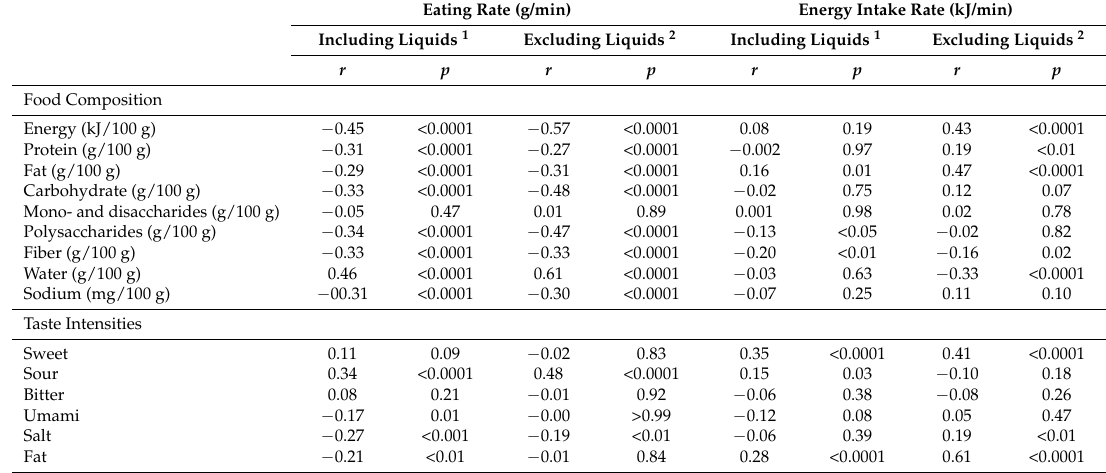
Table 1. Pearson correlations between food-specific eating rate and energy intake rate, and food properties; with and without considering liquids.